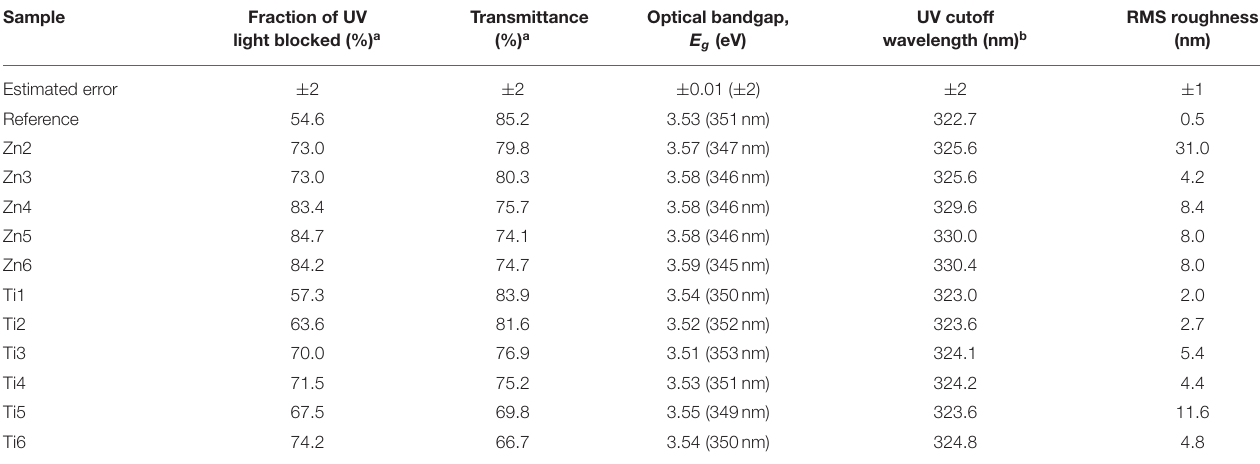
TABLE 3 | Optical properties of coated glass samples, the fraction of the blocked UV light and the transmittance was calculated using (Equation 2). Sample